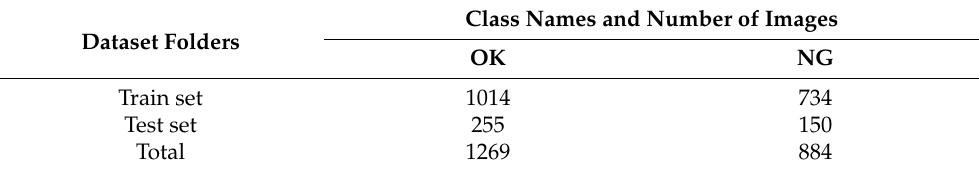
Table 2. Detailed description of the acquired 3D ball joint socket dataset. The dataset was di- vided into training and test sets with 80% and 20%, respectively. OK—non-defective products, NG—defective products.